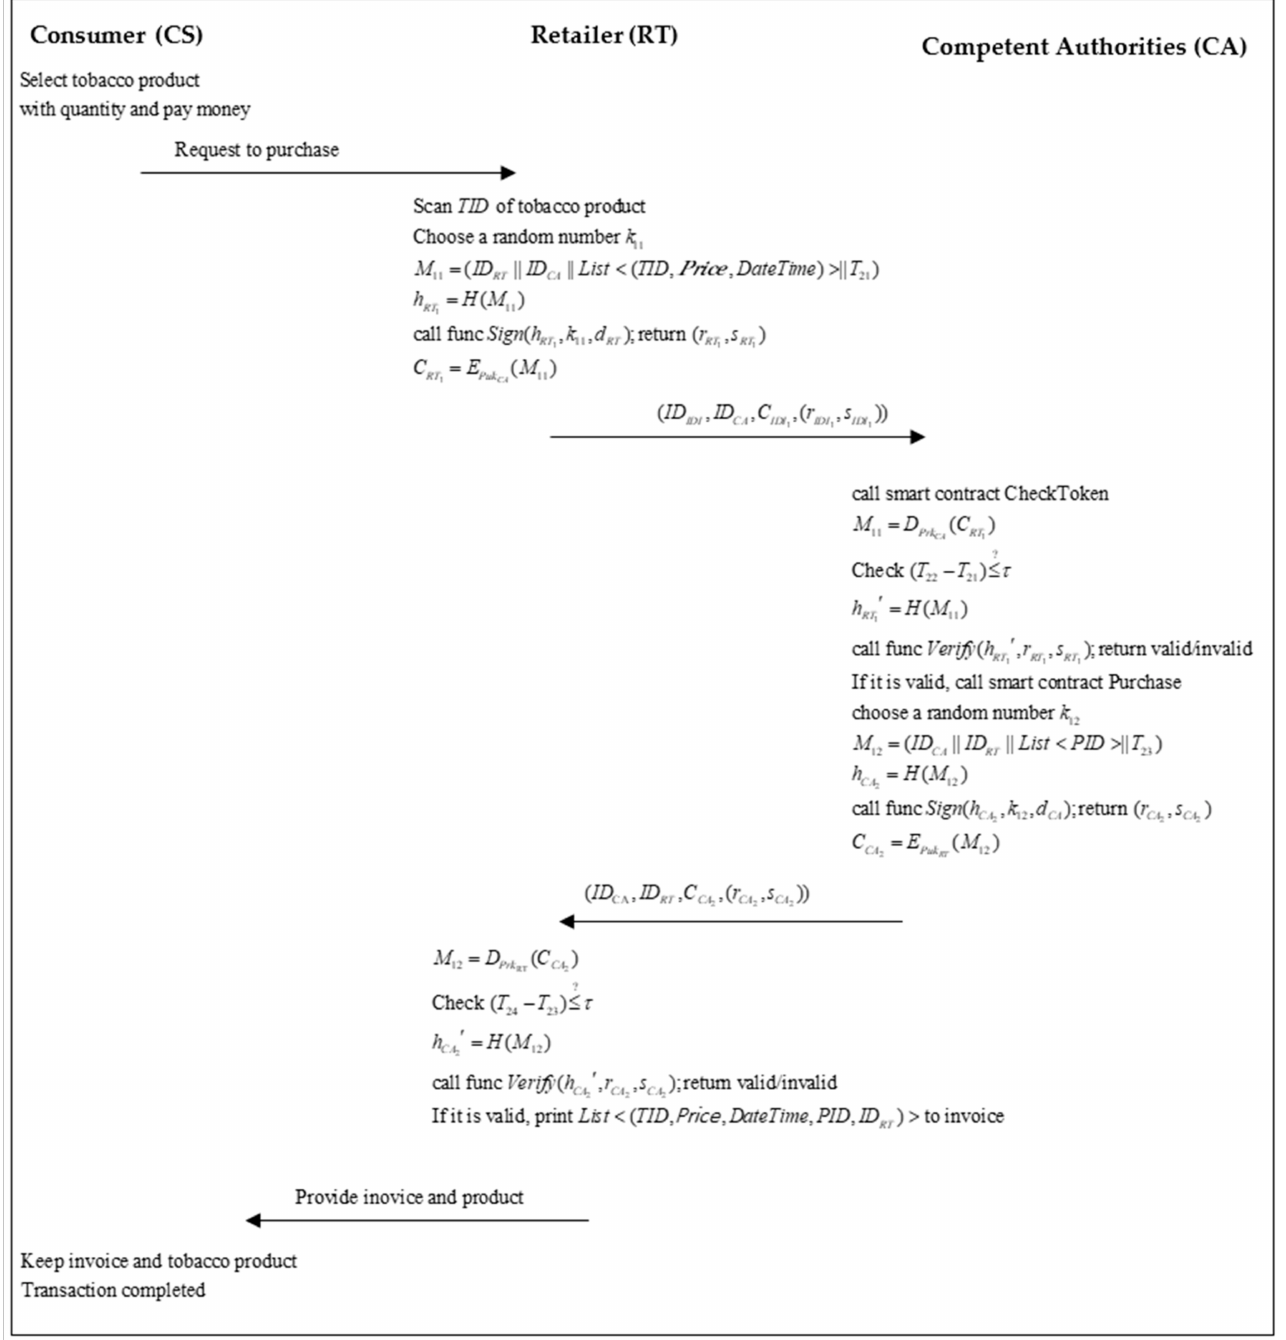
Figure 11. The flowchart of the consumption